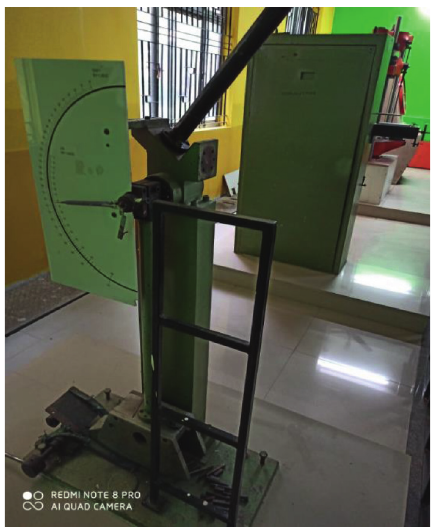
Figure 4: Impact test machine.